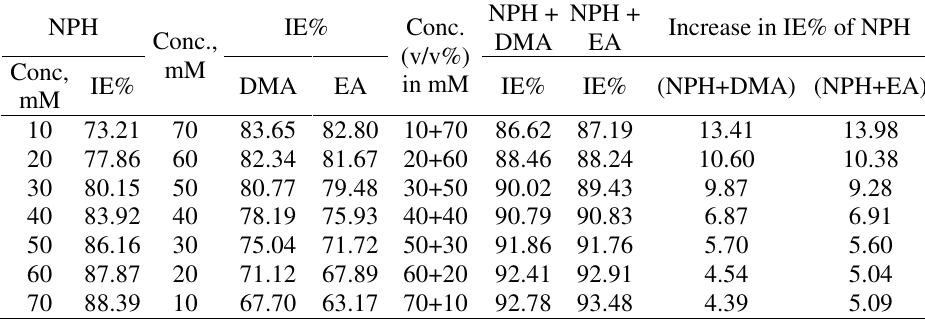
Table 1. Corrosion parameters in presence of the mixtures of NPH and DMA at different concentration